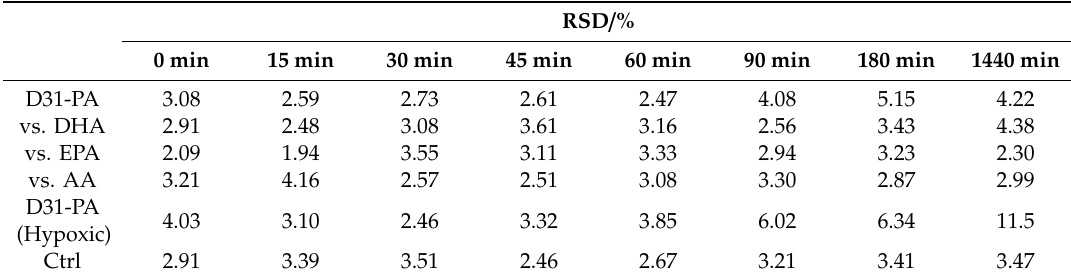
Table A2. RSD calculated in the full spectral region.